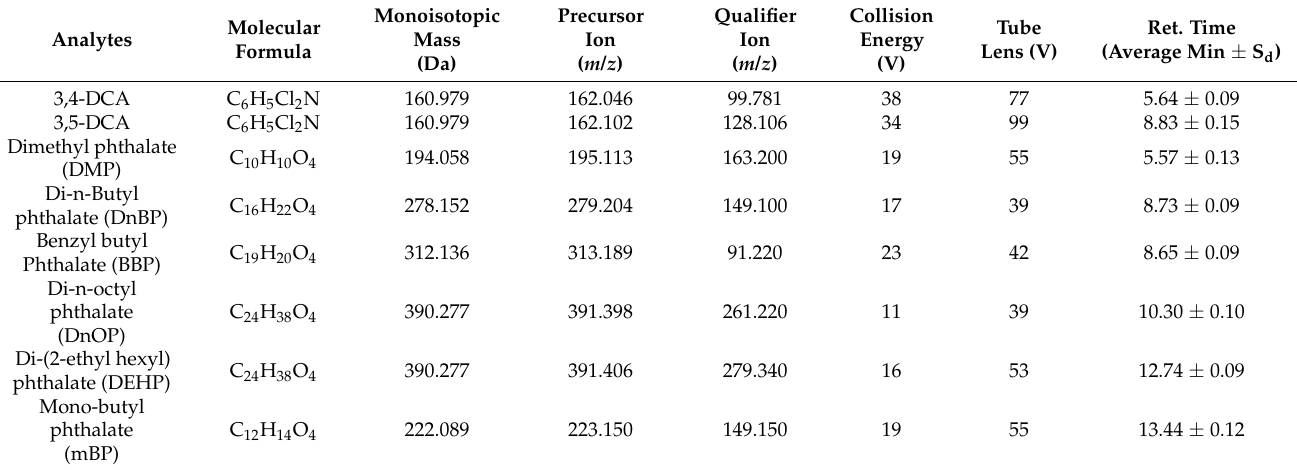
Table 1. Target analytes detection parameters (MRM) and retention